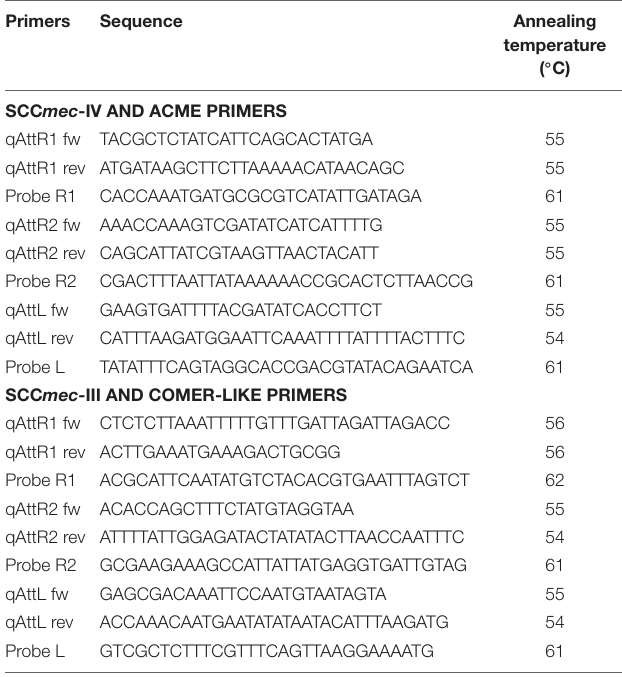
TABLE 2 | Primers and probes used in the